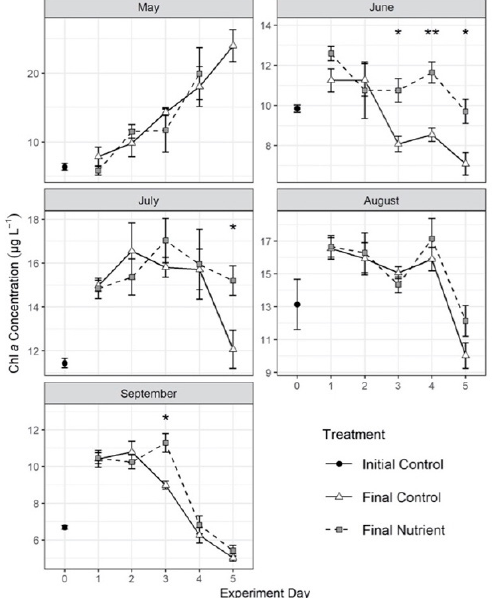
Figure 4. Mean chl a concentration by experiment day for Day 0 initial control, Day 1–5 final control, and Day 1–5 final nutrient ‐ amended samples. Error bars are 1 SE. Asterisks indicate statistically significant p ‐ values for t ‐ tests comparing final control and final nutrient ‐ amended samples. p < 0.05 = *, p < 0.01 = **.